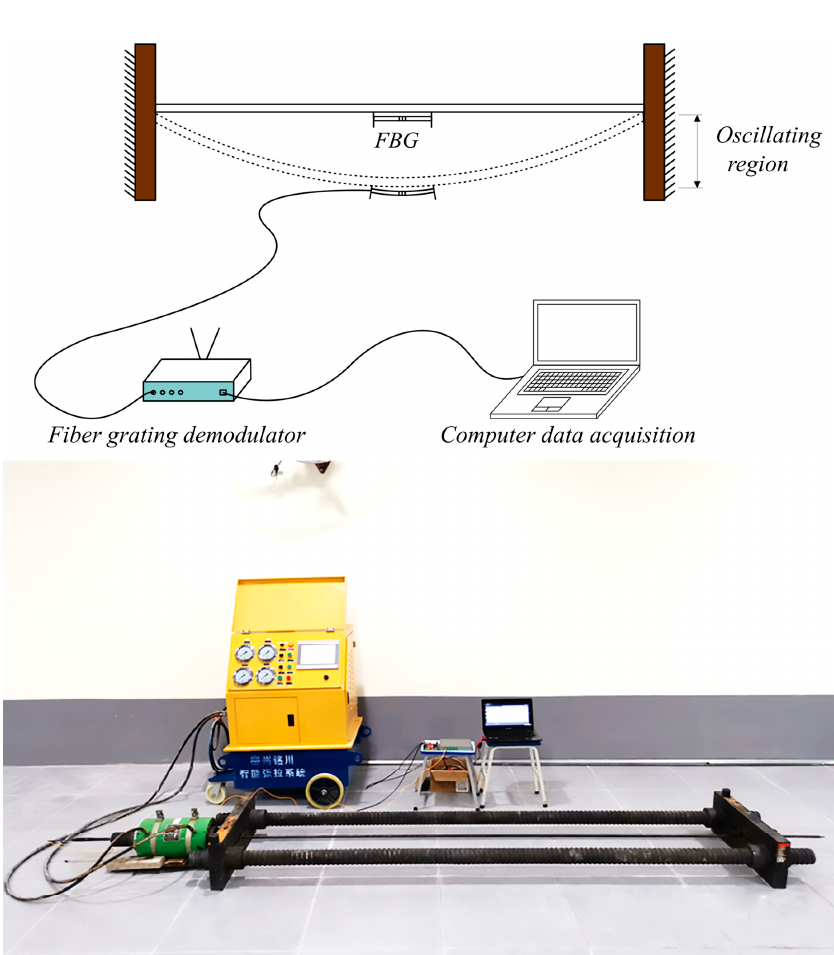
Figure 6. Vibration signal acquisition system schematic. and physical map .